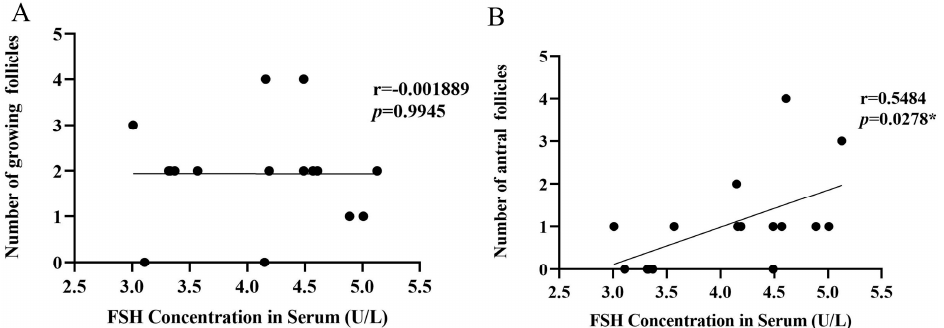
Figure 7. Correlation analysis between the serum FSH concentration and growing follicles number and antral follicles number in Phodopus sungorus . ( A ) Correlation analysis between serum FSH con- centration and growing follicles number. ( B ) Correlation analysis between serum FSH concentration and antral follicles number (* p < 0.05).